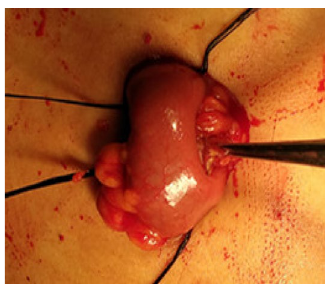
Figure 2. The ileal loop was withdrawn through the opening of the abdominal wall. The intestinal wall and mesentery were intermittently sutured with peritoneum and external oblique aponeurosis. An avascular window was opened in the mesentery and the skin bridge was passed through it. Then the bridge was secured with 2–3 stitches of 2/0 absorbable suture to the distal edge of the